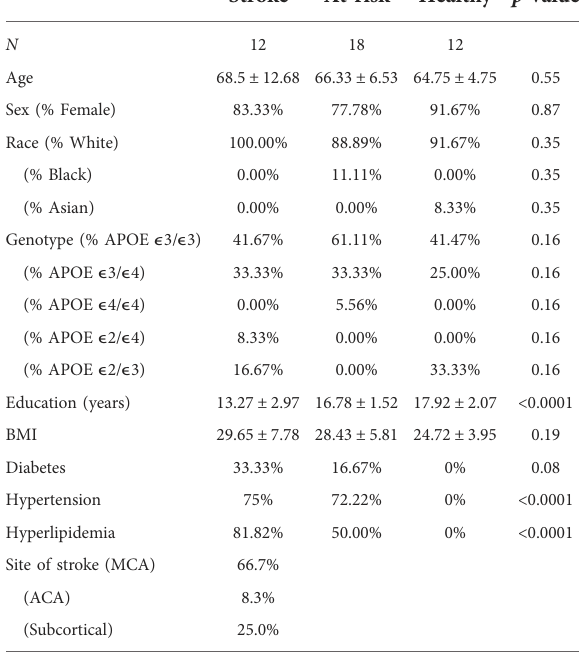
TABLE 1 Participant